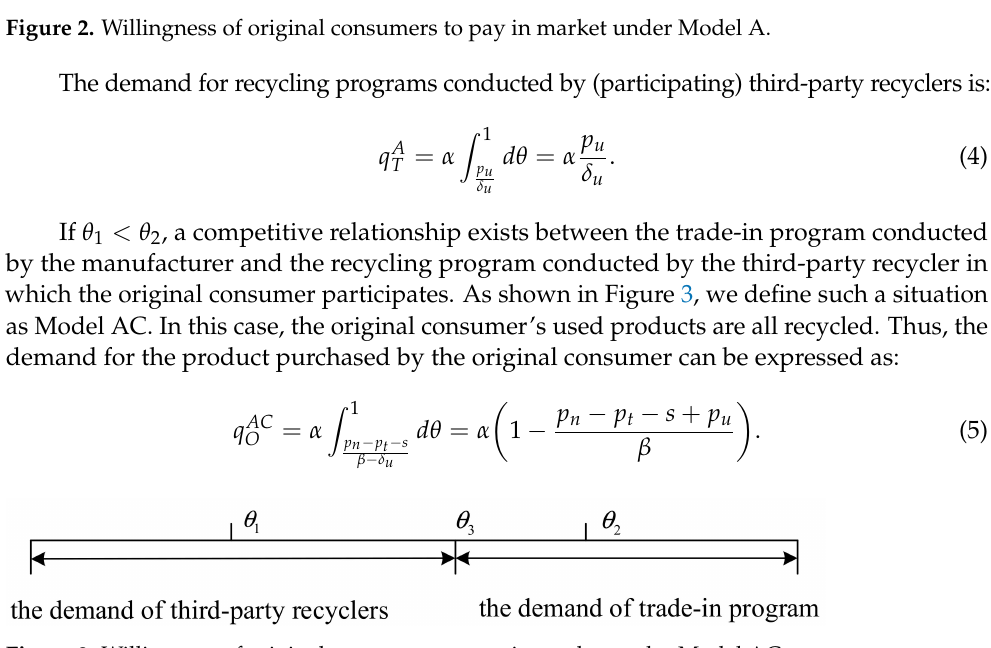
Figure 3. Willingness of original consumers to pay in market under Model